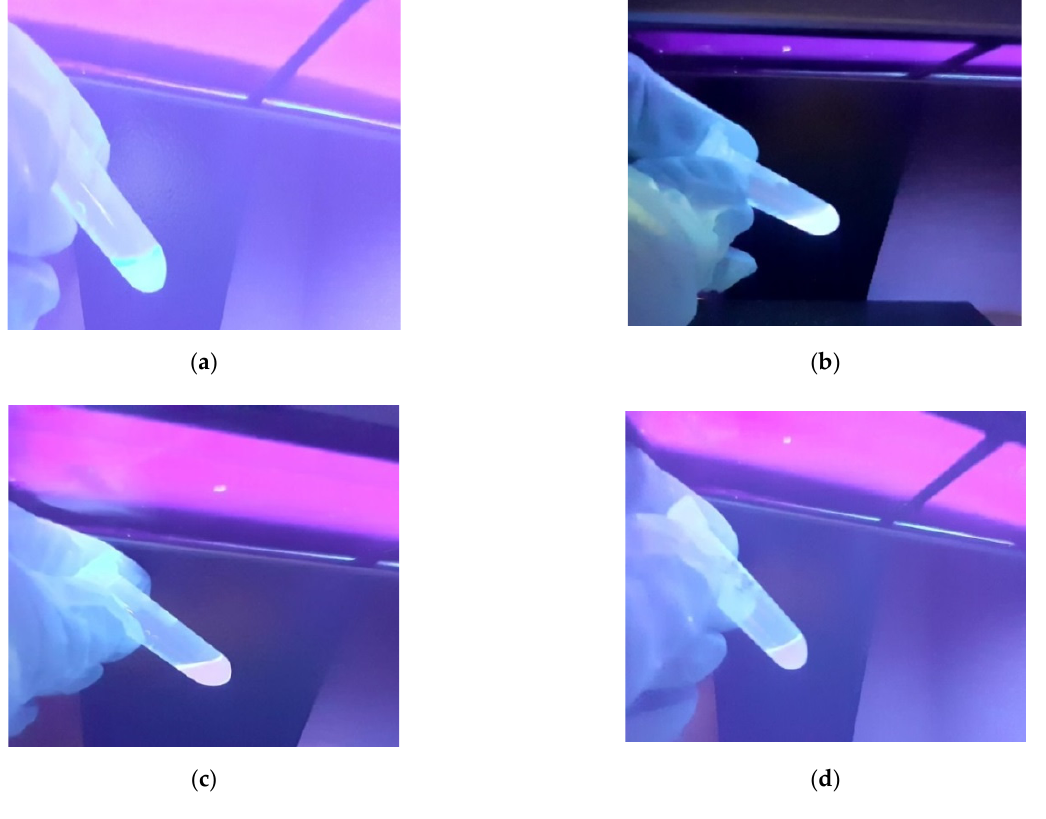
Figure 1. Fluorescence observed in Southern flying squirrel hair extracts under UV light, show- ing pink coloration in ( c , d ) samples. Samples ( a , b ) correspond to back hair, while samples ( c , d ) correspond to ventral